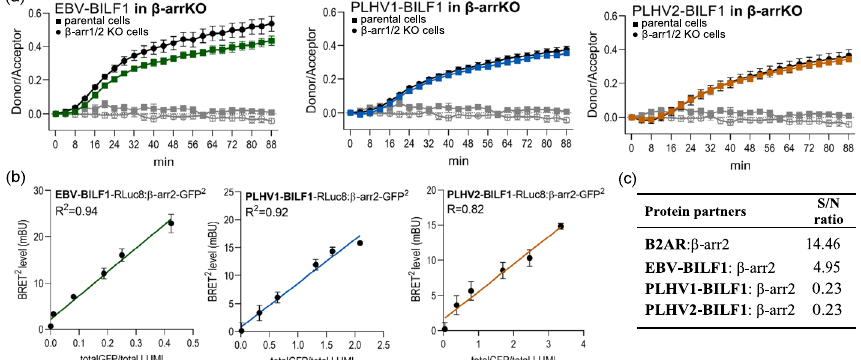
in parental HEK-293A cells (black square) and β-arrestin 1/2 knockout HEK-293A cells (Δβ-arr KO; black circle or white circle for empty vector). The curves represent the ratios between the donors and acceptors. Internalization was measured every 4 min for 88 min at 37 °C. b BILF1 receptors C-terminally tagged with RLuc8 were expressed in HEK-293A cells together with various concentrations of β-arr 2-GFP 2 . BRET2 values are plotted as a function of the ratio between the GFP 2 (total fluorescence) and RLuc8 (total luminescence) signal. Results are presented as the mean ( SEM) from at least three independent experiments and are fitted ± using a simple linear regression equation ( R ). c The table presents the results from the informational spectrum method (ISM), determining the interaction of BILF1 receptors or the β2 adrenergic receptor (β2-AR) with β-arrestin (S/N ratio). A lower S/N ratio indicates lower interaction